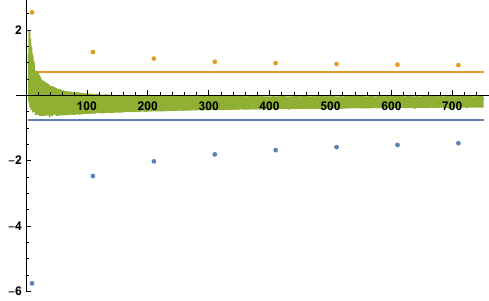
Figure 6 . We plot s Vir ( δ, ∆) (green) versus ∆ as defined in (1.6) for the non-chiral Monster CFT partition function for δ = 2 . 4 as a function of ∆. The straight lines correspond to the upper s Vir (orange) and lower s Vir − ( δ ) (blue) asymptotic bounds. We see that the actual microscopic entropy s Vir ( δ, ∆) is oscillatory, however, the amplitude of oscillations lays well within the asymptotic bounds for ∆’s greater 20. Of course, as in the 2d Ising model the actual ∆ bounds are weaker ≃ and are given by